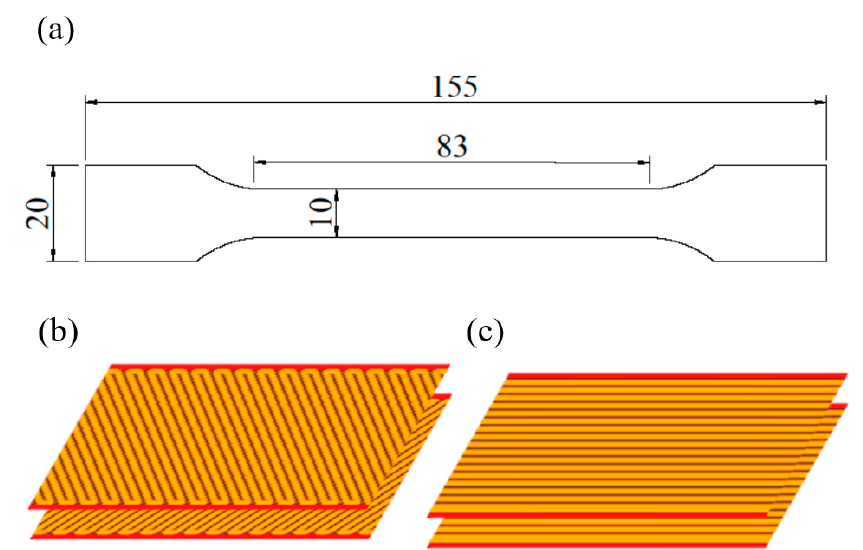
Figure 1. ( a ) The geometry of the tensile test specimen with printing raster angles of ( b ) (45, 135) and ( c ) (90, 90).